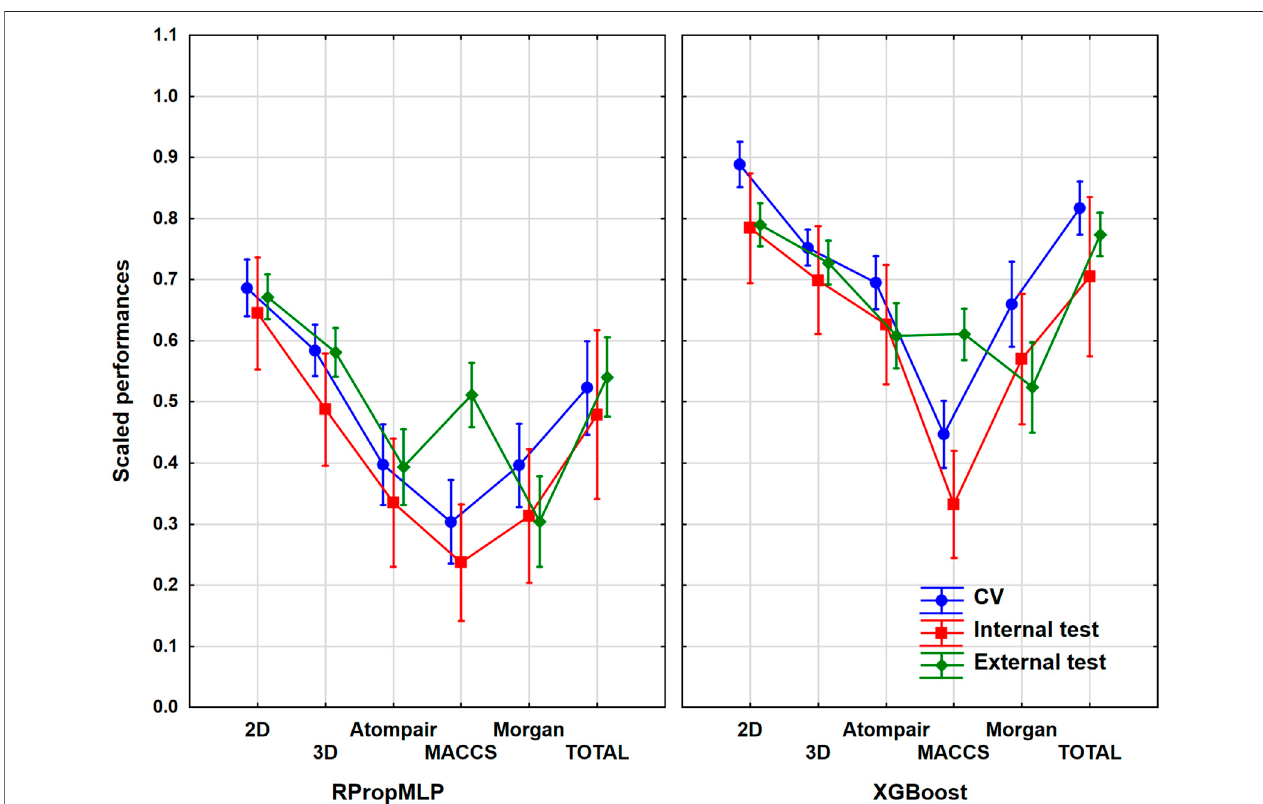
FIGURE 6 | Scaled performances of the models in the case of the Ames mutagenicity dataset based on the molecular descriptor types and machine learning algorithms. The 18 performance parameters were range-scaled between 0 and 1 and averaged across all models with the given descriptor types/ML algorithms. The resultofCV ismarkedwithblue, theinternaltestresultismarkedwithred,andtheexternaltestismarkedwithgreen.Themeanofthescaled performanceparametersis plotted in each case with the 95% con fi dence intervals.